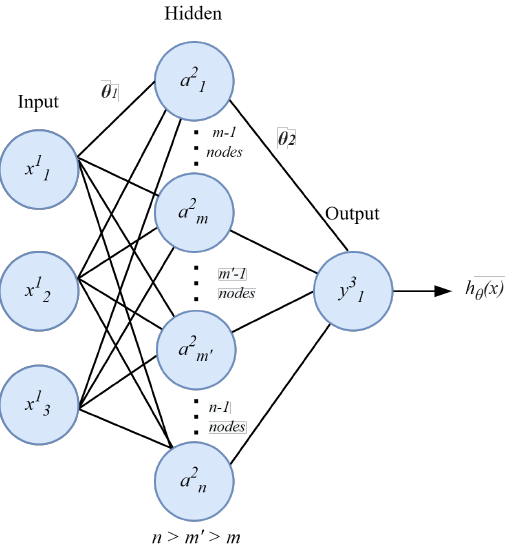
Figure 7. An abstract view of multilayer perceptron model